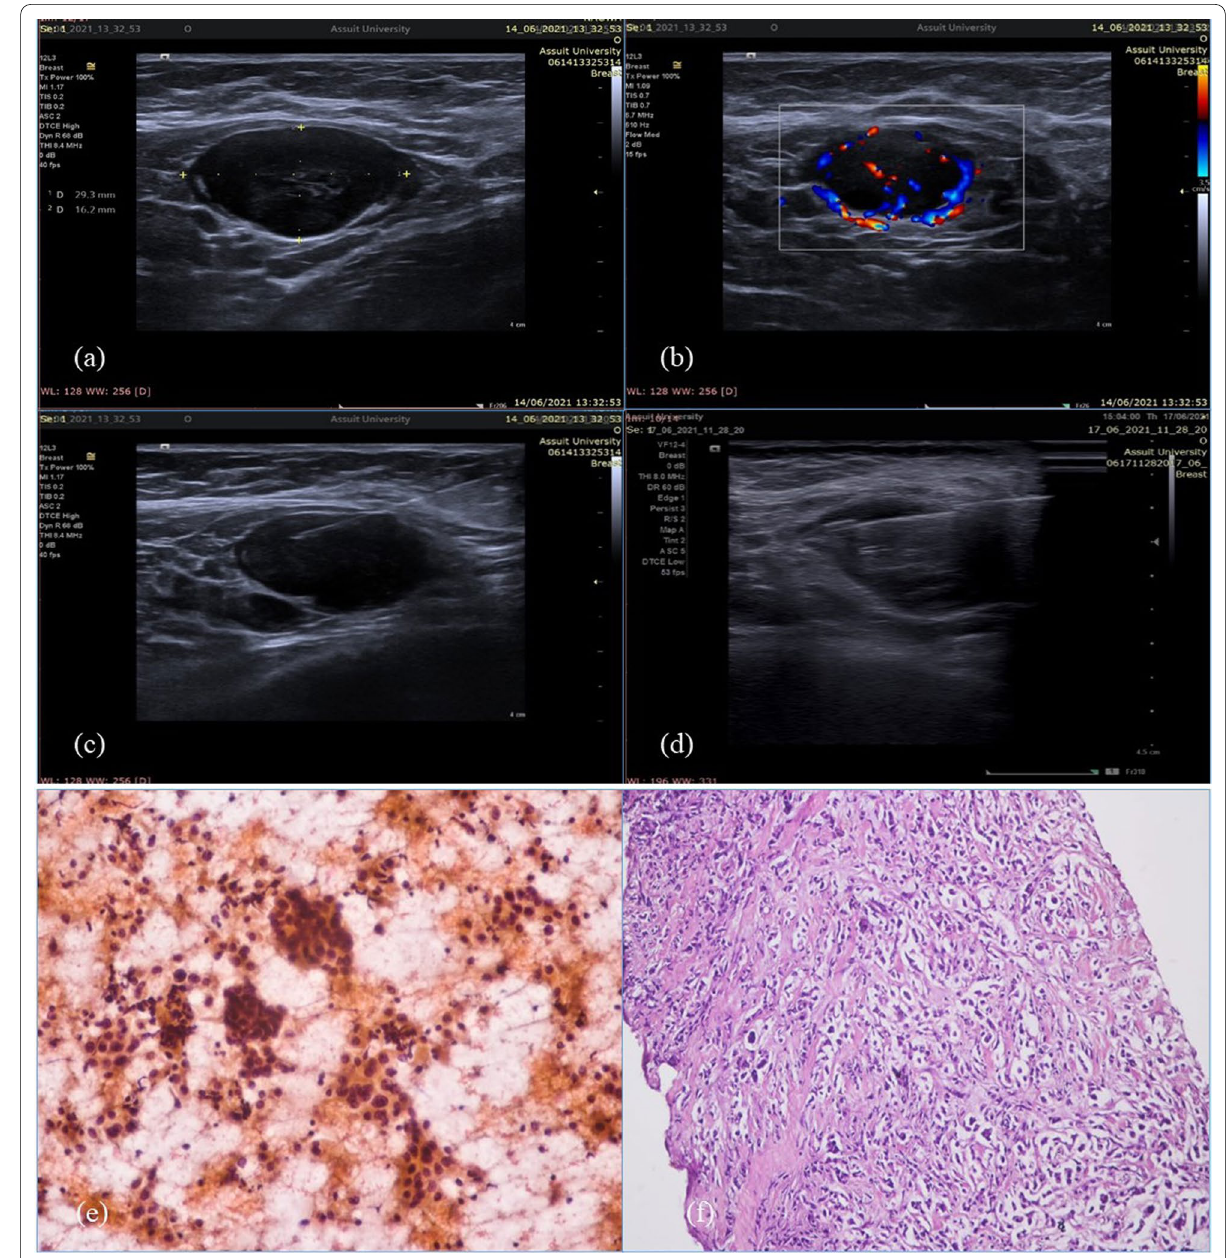
Fig. 4 An 42‑year‑old female patient presented with breast cancer, the freehand technique was used and under ultrasound guidance, FNAC & core biopsy were obtained simultaneously, and the final histopathological evaluation showed metastatic lymph nodes harboring malignancy. a Axillary gray‑scale ultrasonographic image demonstrates a suspicious lymph node, measuring 30 16 mm. It is oval in shape with effaced hilum. × b Doppler US image shows that the lymph node has both hilar vascular flow as well as prominent cortical non‑hilar blood flow at the periphery. c Needle pass during FNAC in the cortical region of the lymph node. d Needle pass during Tru‑cut biopsy of the lymph node from cortical regions. e Photomicrograph of a lymph node cytology smear: multiple clusters of malignant epithelial cells on the lymphoid background (Papanicolaou stain, 400X). f Photomicrograph of tissue section of metastatic ductal carcinoma in the lymph node. Many nests and cords of neoplastic cells are separated by desmoplastic stroma (Hematoxylin and Eosin stain,